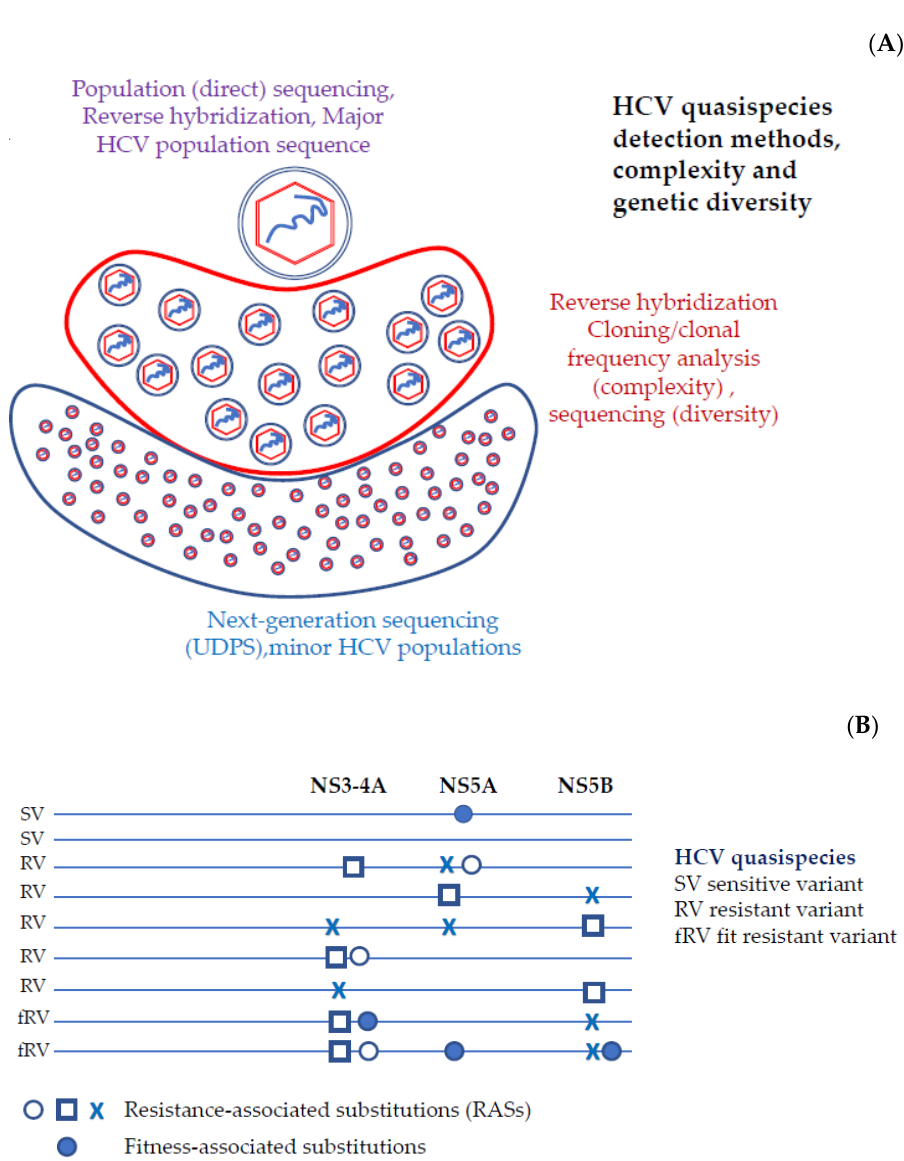
Figure 1. ( A ) The “cloud” of HCV quasispecies in the space of sequences; Mixture of virions that are genetically distinct but closely related. The assay methods for the detection of major populations should report the presence of RASs with a validated and repeatable sensitivity of 15%, equivalent to population sequencing. The number of different variants and their relative frequency give estimated measures of complexity and the genetic distances measures of diversity. ( B ) Viral variants are individual full-length viruses that constitute the HCV quasispecies in a patient. Resistant variants contain one or several RASs, which are single amino acid changes that reduce susceptibility to a DAA or a class of DAAs. Fitness associated substitution(s) are single amino acid changes that do not alter DAA susceptibility but increase the fitness of the resistant variants.